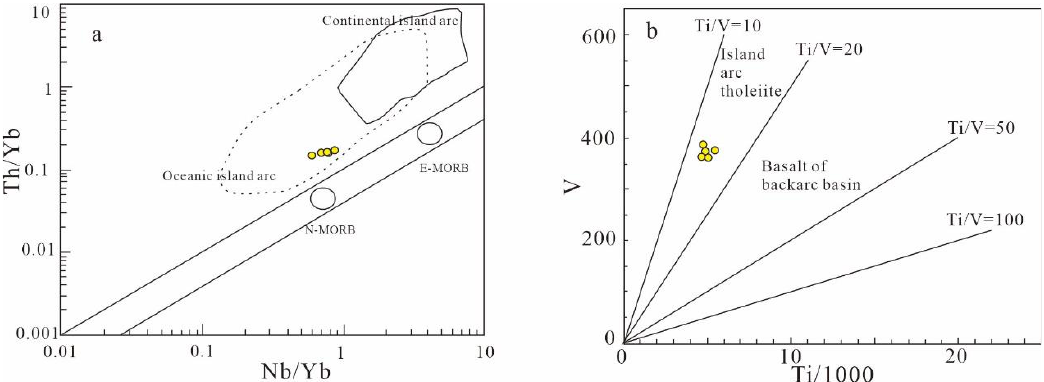
Figure 11. Diorite dyke structure discrimination diagram. ( a ) Nb/Yb-Th/Yb diagram (after Xu et al. [72]); ( b ) Ti-V diagram (after Shervais [73]).